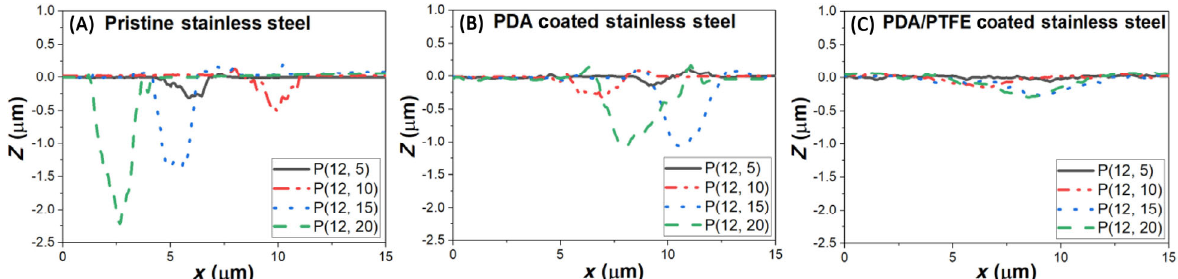
Fig. 5 Surface topography profile of the textured grooves on (A) pristine, (B) PDA-coated, and (C) PDA/PTFE-coated laser textured stainless steel measured by